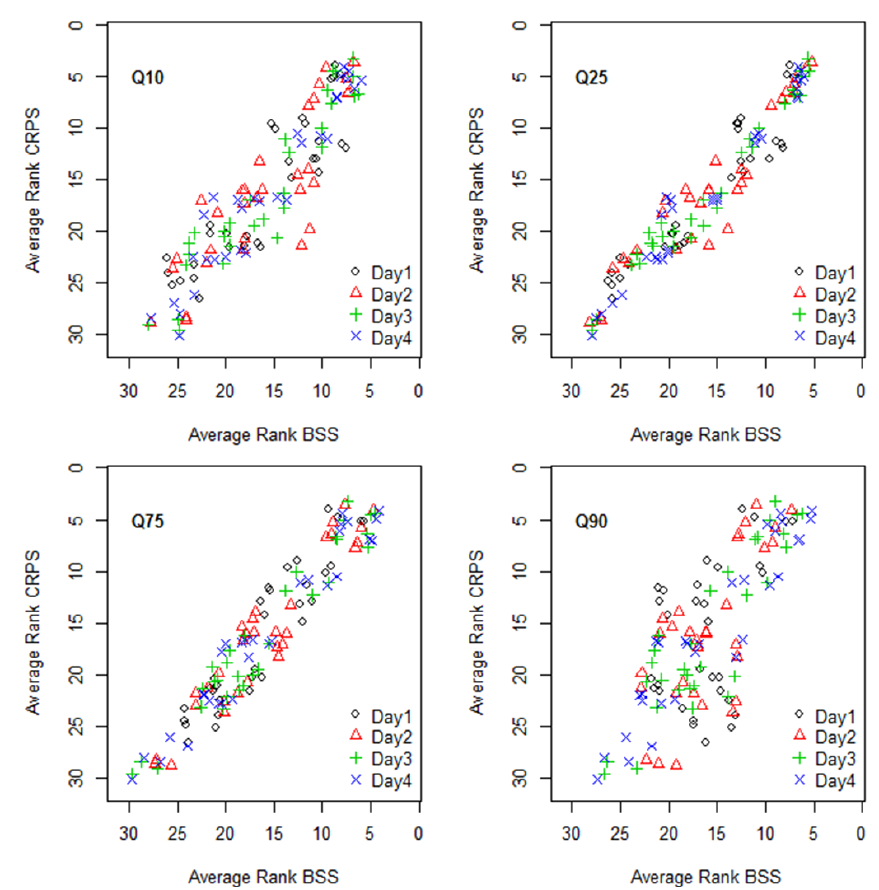
Figure 9. Comparing average rank across 82 gauges based on Brier skill score and